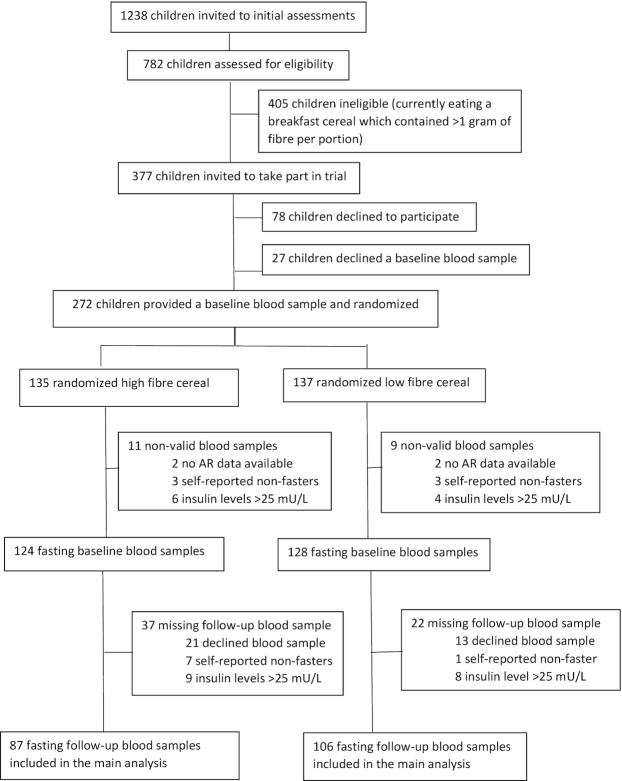
Trial participant recruitment, randomization, and follow-up. AR, plasma total alkylresorcinol.